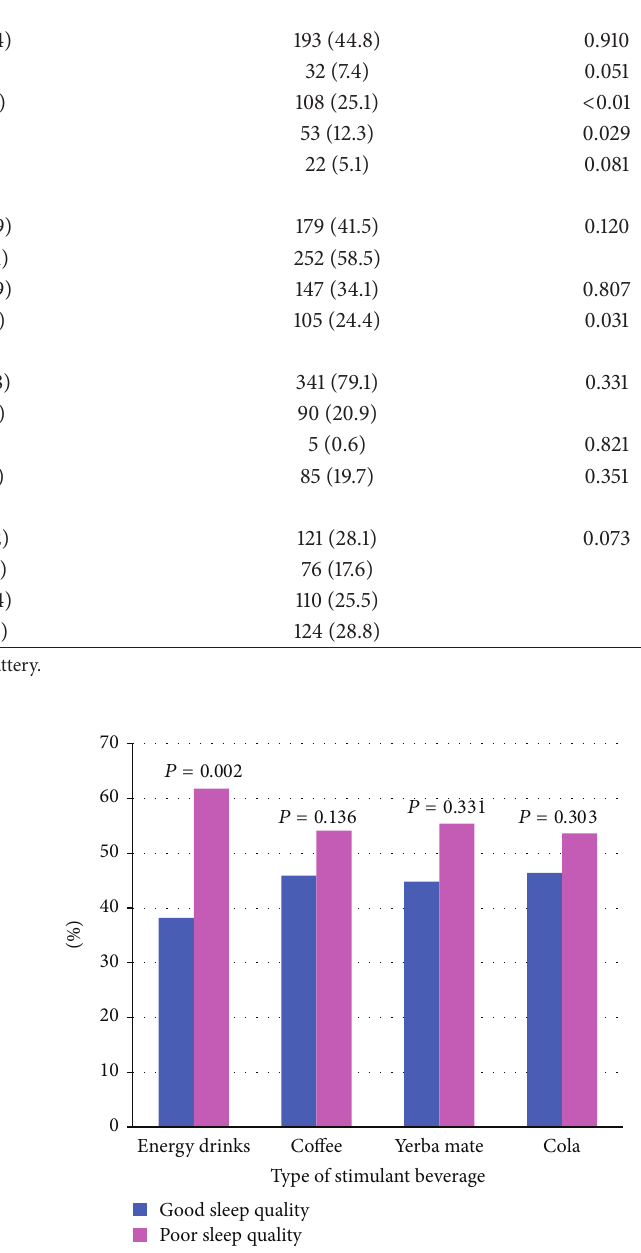
Figure 3: Sleep quality according to types of stimulant beverage